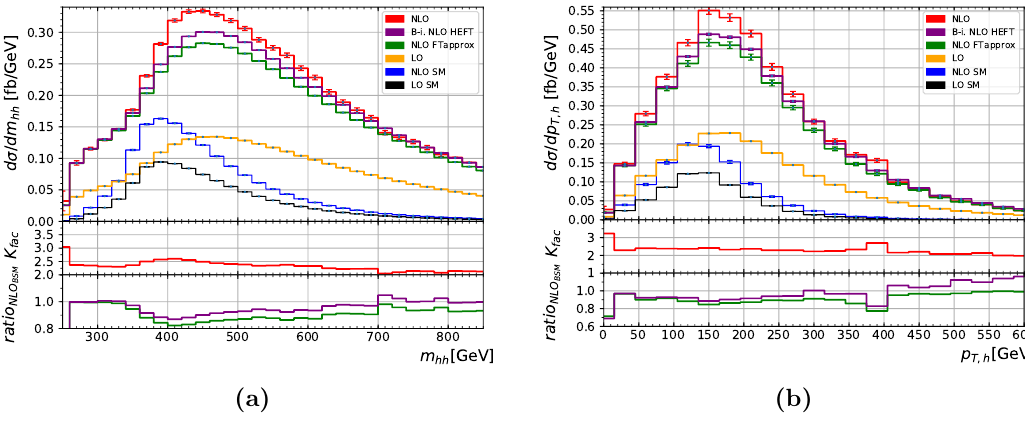
Figure 21. Same as (cid:12)gure 12 but for benchmark point 9, c hhh = 1 ; c t = 1 ; c tt = 1 ; c ggh = (cid:0) 0 : 4 ; c gghh = (cid:0) 0 :